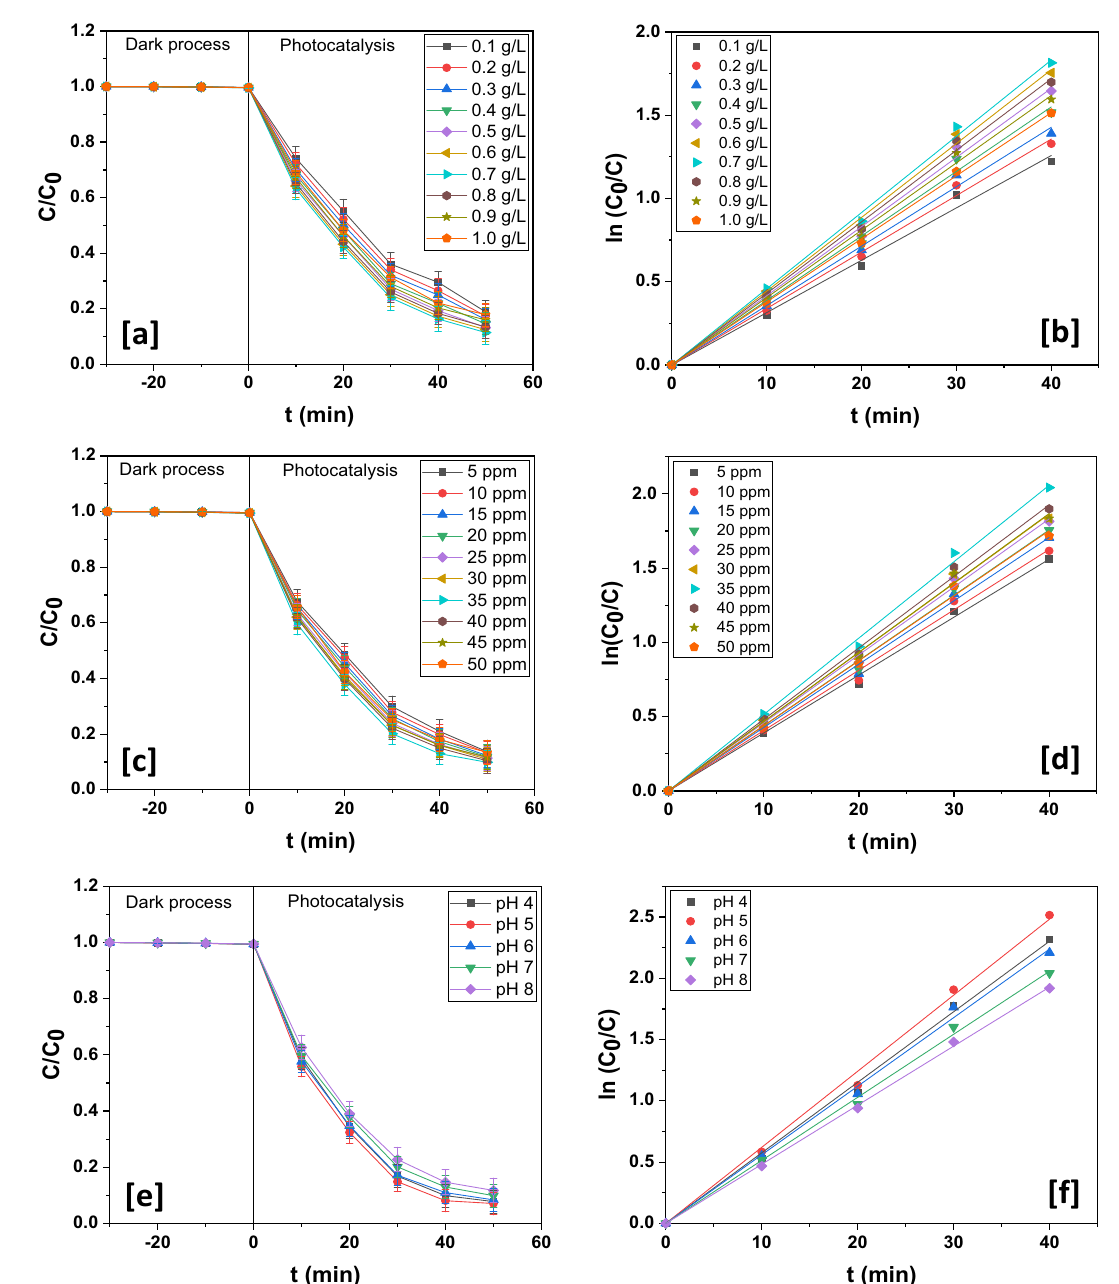
Figure 7. ( a ) Photodegradation dynamic curves of esomeprazole at different catalyst loading In 2 O 3 /MoS 2 / Fe 3 O 4 and ( b ) its corresponding kinetics. ( c ) Photodegradation dynamic curves of esomeprazole at different esomeprazole concentration loading over /MoS 2 /Fe 3 O 4 and ( d ) its corresponding kinetics. ( e ) Photodegradation dynamic curves of esomeprazole at different pH over In 2 O 3 /MoS 2 /Fe 3 O 4 and ( f ) its corresponding